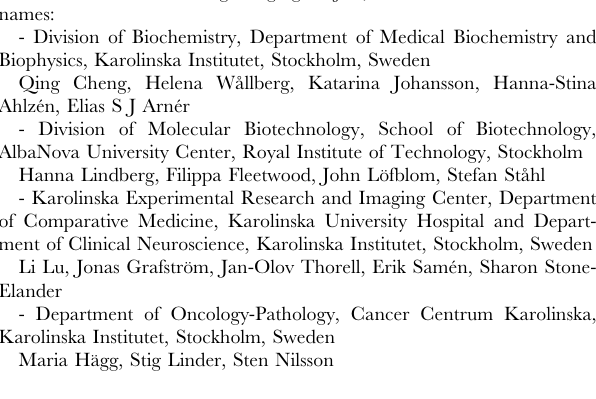
Figure S1 AnxA5-ST maintains specific binding to apoptotic cells when labeled with fluorescence at its Sec residue whereas mTrx-GFP-ST does not bind apoptotic cells. Fluorescence microscopy (top) or phase contrast (bottom) pictures of FaDu cells exposed to 0.2 m M doxorubicin for 48 hours and incubated with 0.5 m g/ml of either [AF]-AnxA5-ST (left) or [AF]-mTrx-GFP (right) for 20 min at 37 u C. Fluorescence labeling at the Sel-tag was performed as described in the Materials and Methods section.